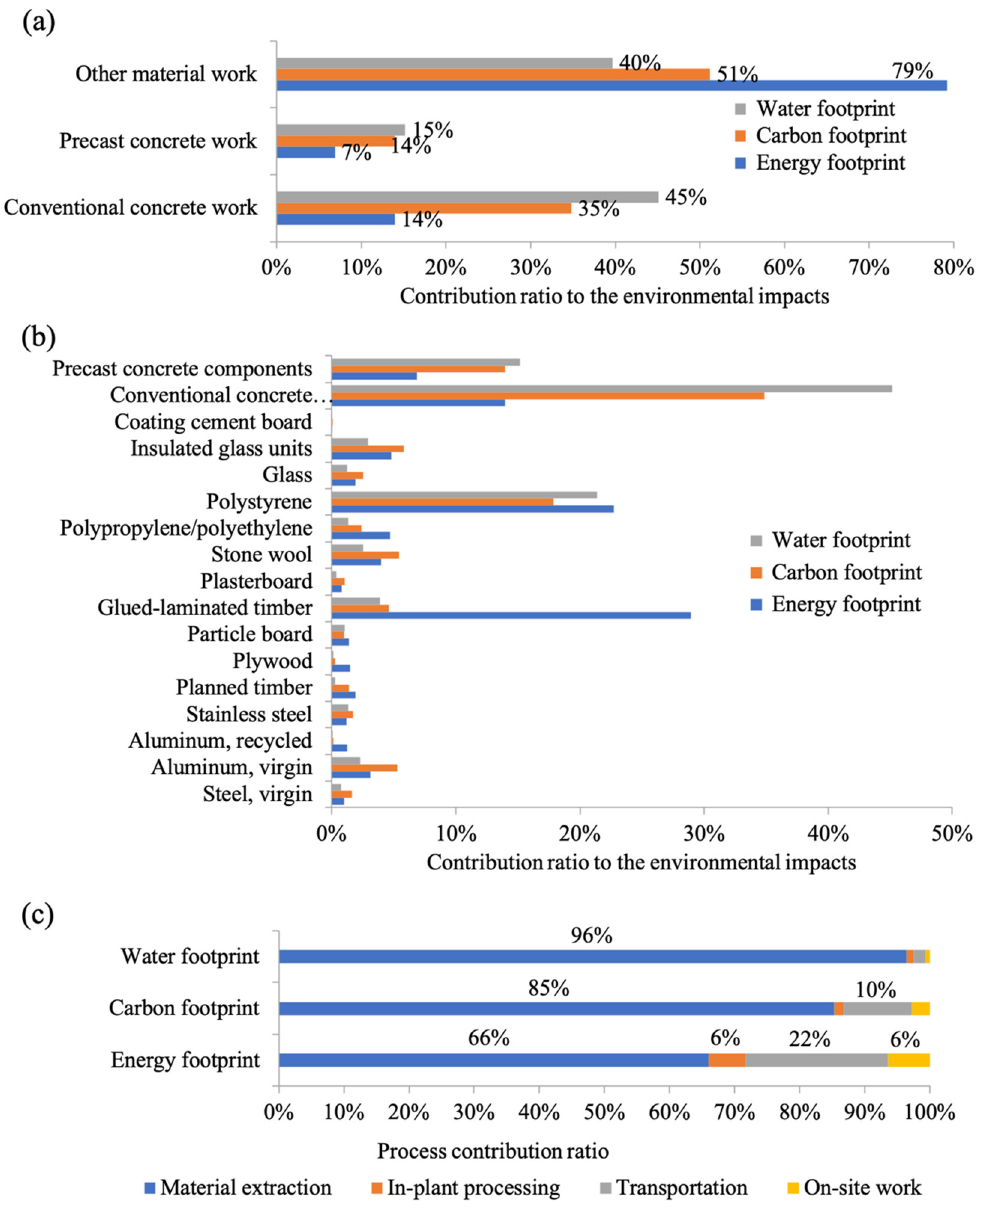
Figure 2. The contributions of ( a ) different work types, ( b ) different building materials, and ( c ) different lifecycle stages to the overall environmental impacts of the reference building.